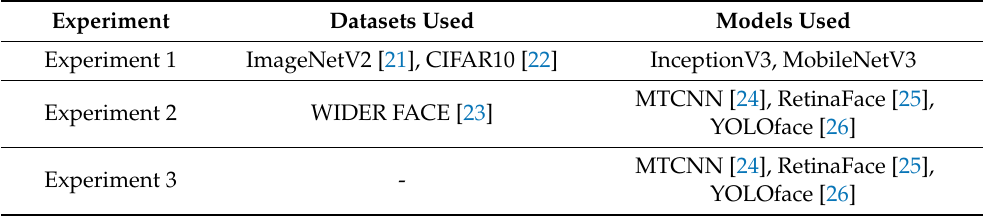
Table 3. Datasets and models used in Experiments 1 to